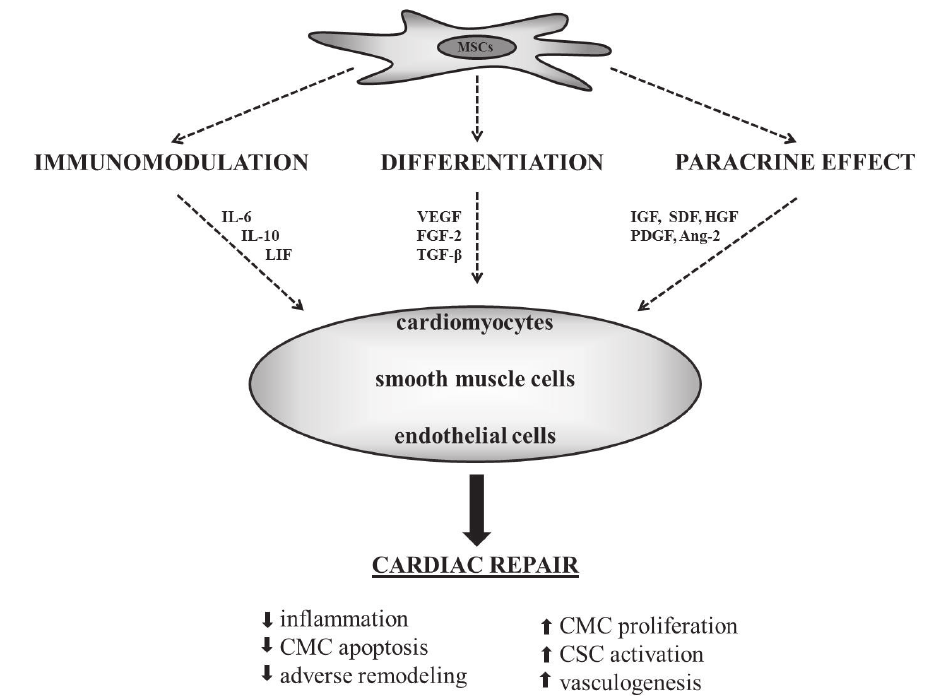
Fig. 1. Scheme of MSCs effect on CMCs and cardiac repair. Differentiation, paracrine effect and immunomudulation – three postulated mechanisms of action of MSCs on damaged cardiac tissue. Cardiomyocytes, smooth muscle cells, endothelial cells and fibroblasts are influenced by MSCs and participate in cardiac tissue regeneration. MSCs-mesenchymal stem cells, CMCs-cardiomyocytes, CSCs-cardiac stem cells, ILs – interleukins, VEGF- vascular endothelial growth factor, FGF-2-fibroblast growth factor-2, TGF-β-transforming growth factor-β, IGF-insulin-like growth factor, SDF-stromal cell-derived factor, HGF-hepatocyte growth factor, PDGF-platelet-derived growth factor,